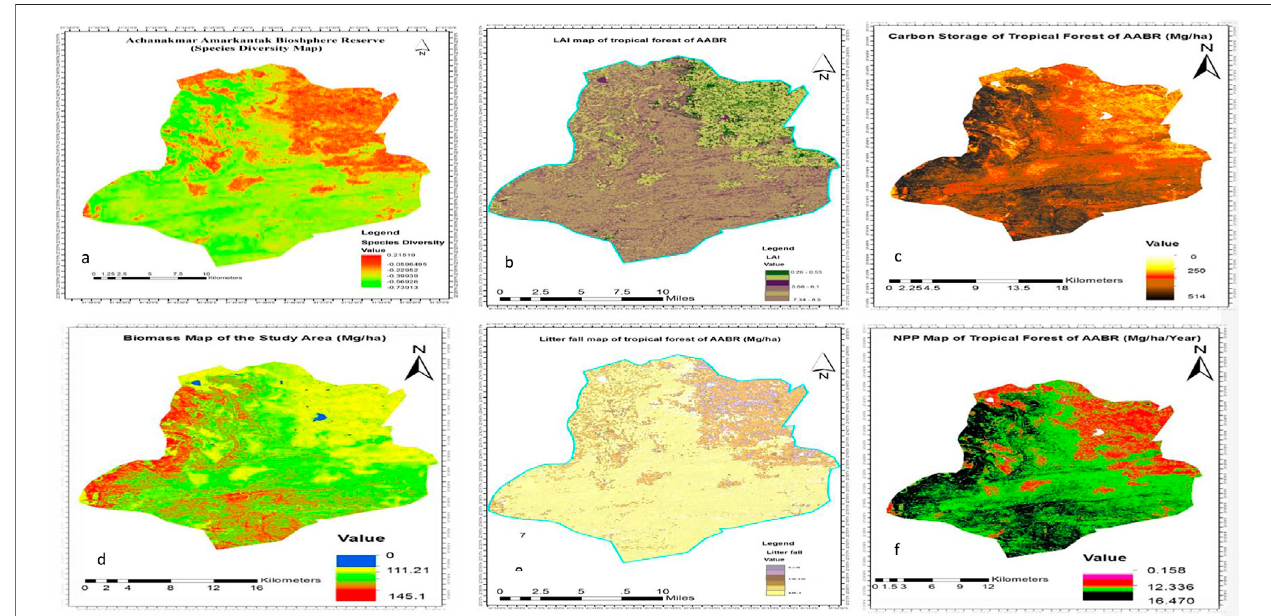
FIGURE 11 | (A) Species diversity map of AABR; (B) Leaf area index map of study site; (C) Carbon storage map (Mg/ha); (D) Biomass map (Mg/ha), (E) Litterfall production map (Mg/ha); (F) Net primary productivity map (Mg/ha/yr).